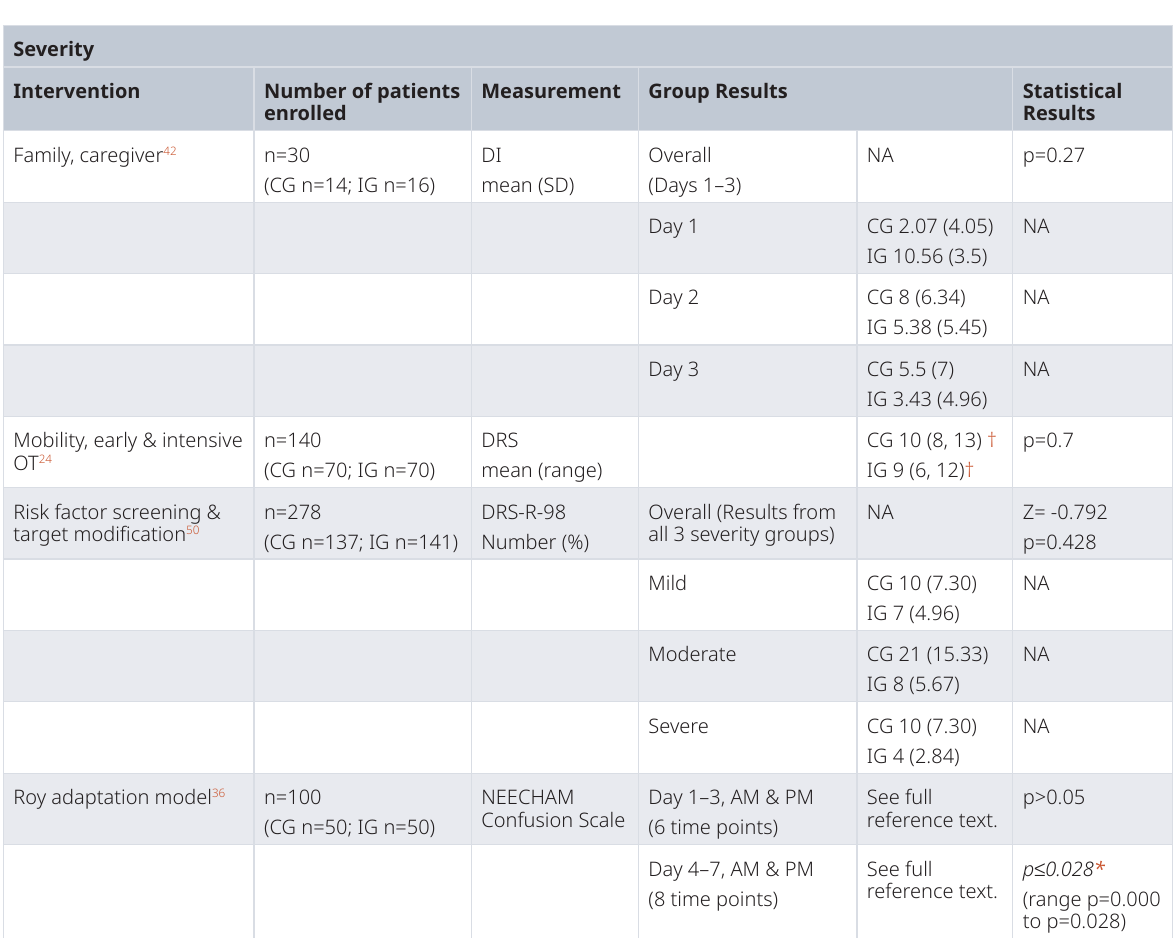
Table 5. Results on severity of